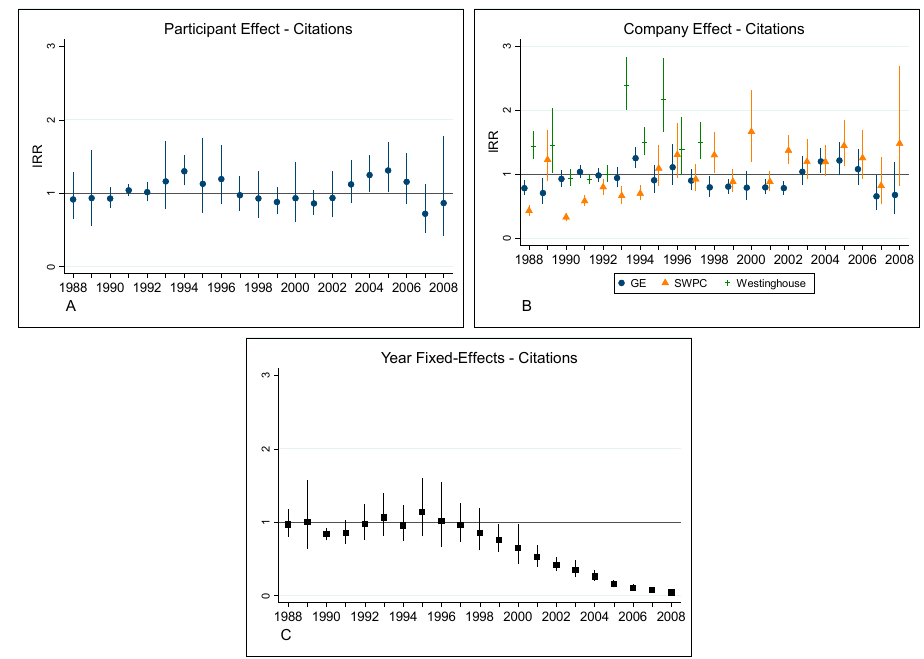
Figure 6. The coe ffi cient results from the citation models with 95% confidence intervals, represented as incidence-rate ratios, and the years of the program outlined in red. ( A ) is the joint treatment e ff ect for the program participants, while ( B ) represents coe ffi cients for participant companies separately. ( C ) is the year fixed-e ff ects for the citation